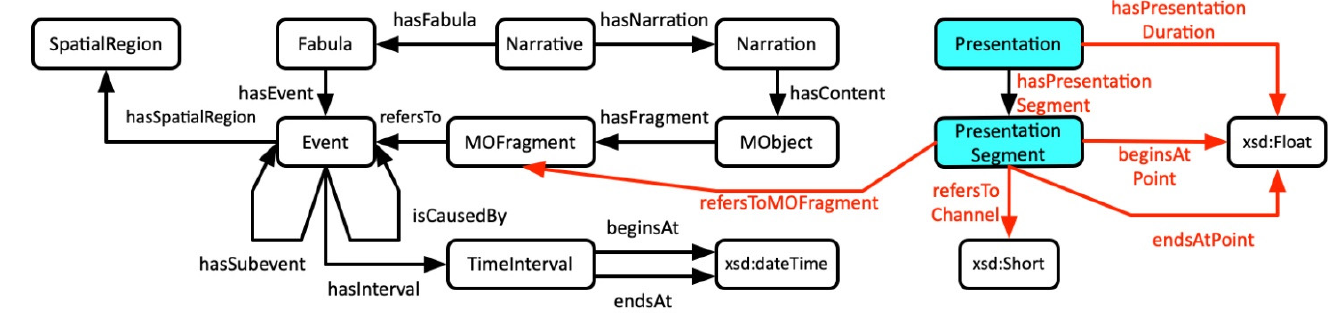
Figure 14. Classes and properties of the CrO+. The classes in green and the properties in red are added to the CrO to represent presentations.